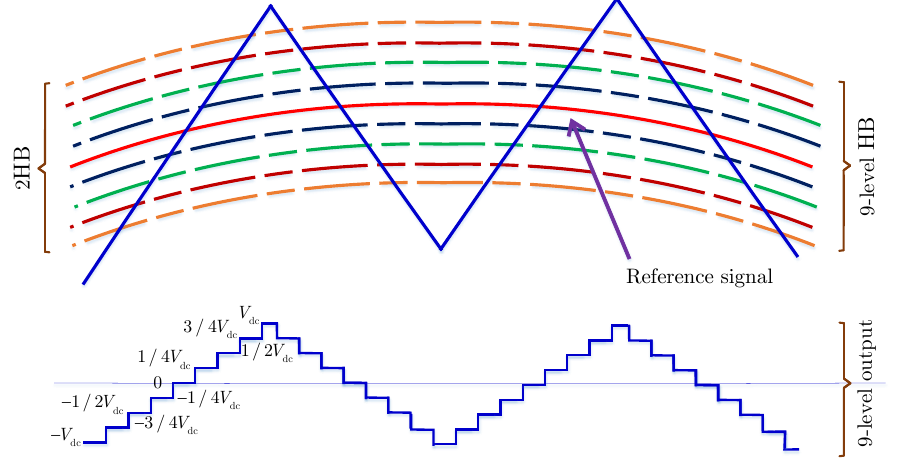
Figure 7. The nine-level adaptive hysteresis band. Table 1. Fuzzy groups used to determine the bandwidth.